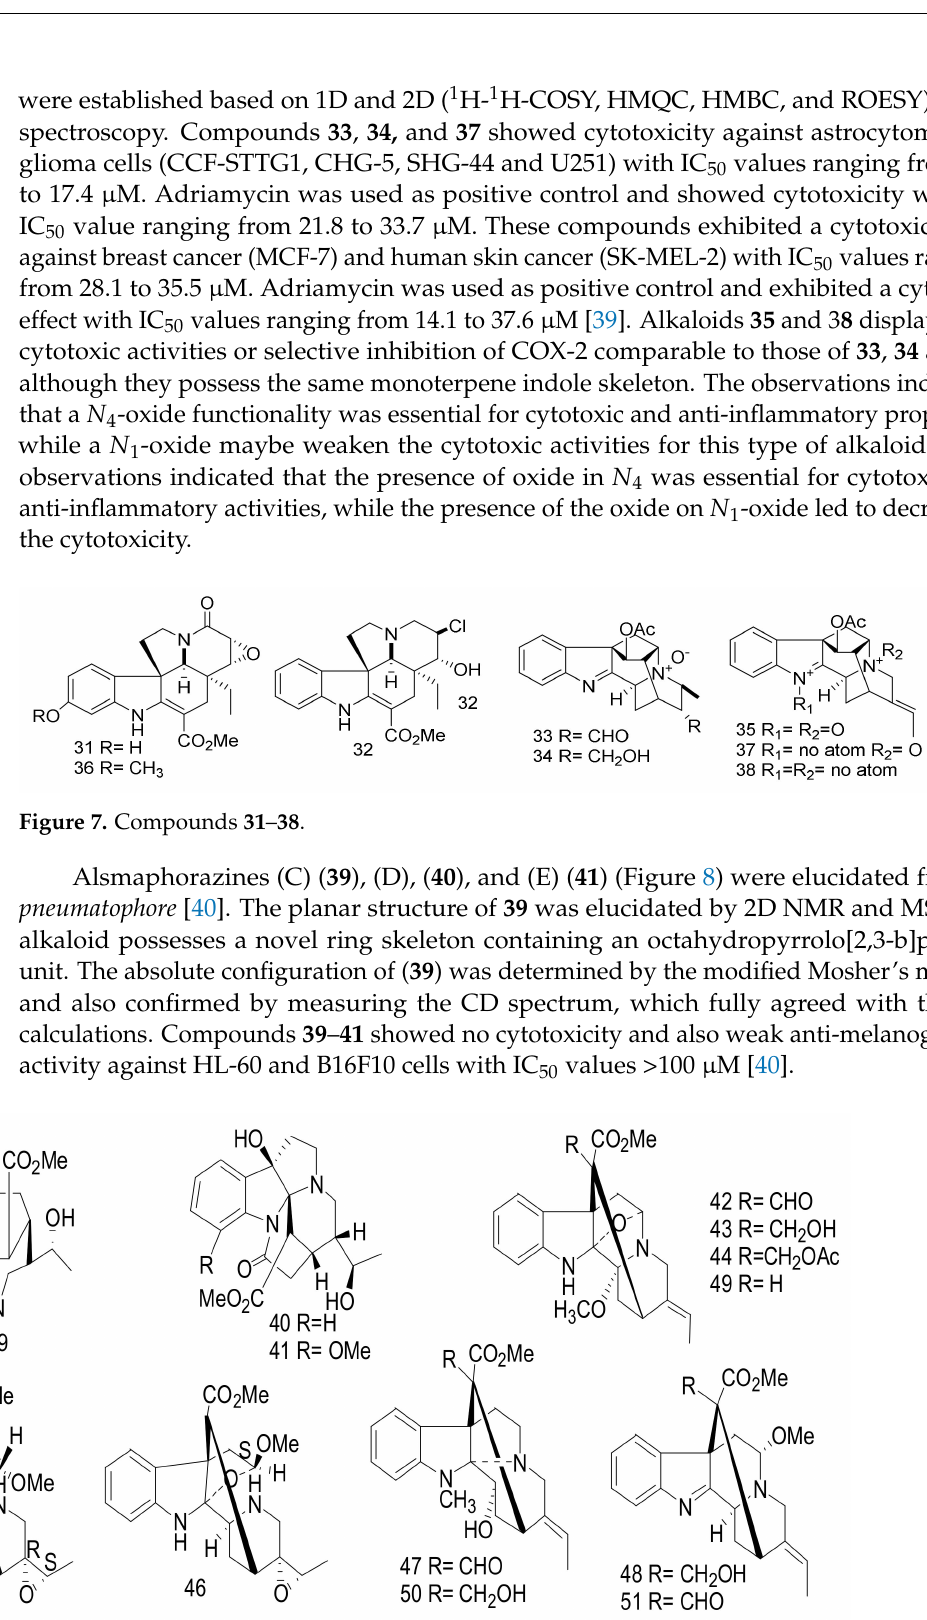
Figure 8. Compounds 39 – 51